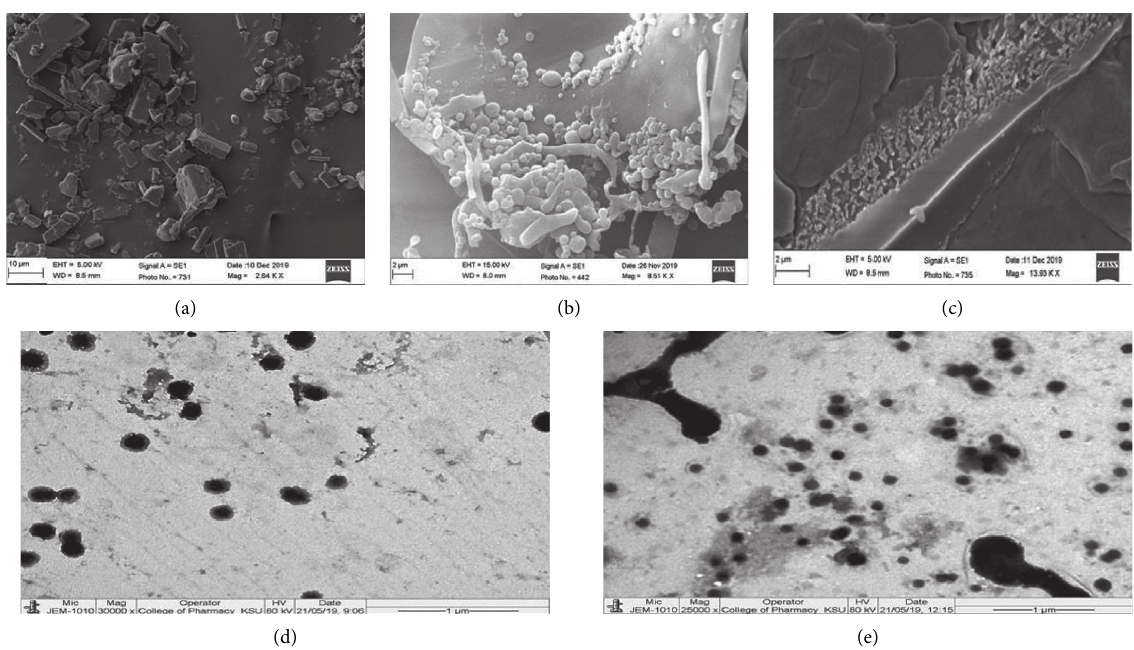
Figure 2: SEM micrographs of (a) pure NAR, (b) HPMC-stabilized nanosuspension, and (c) SDS-stabilized nanosuspension. (d, e) TEM images of HPMC- and SDS-stabilized